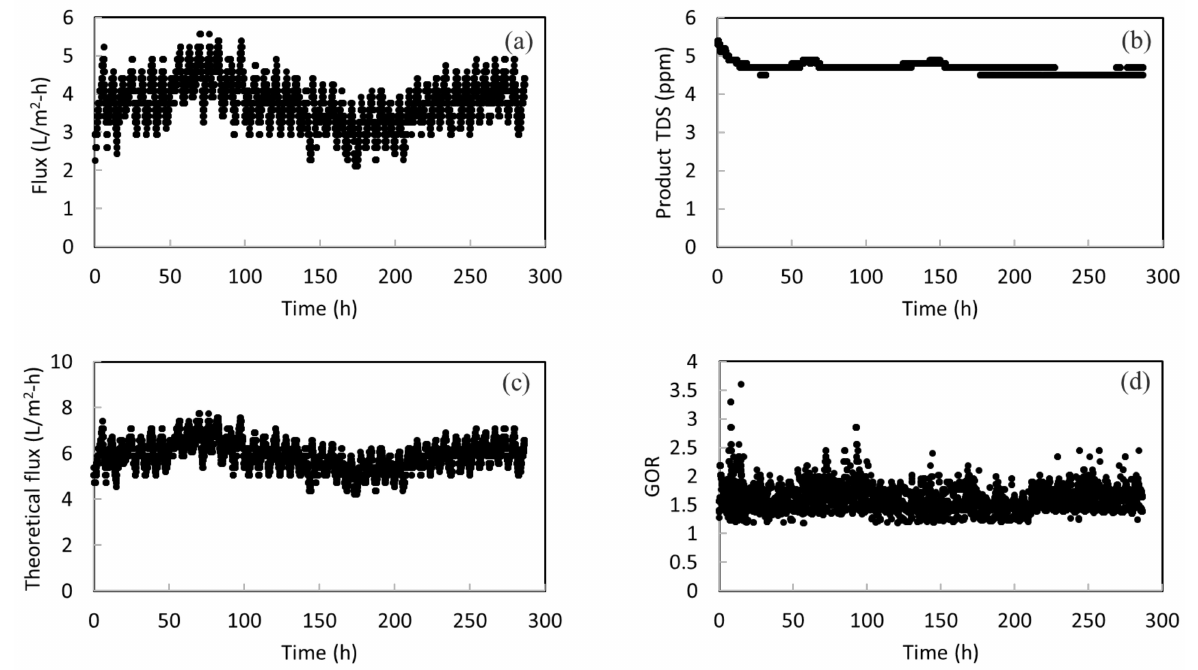
Figure 5. ( a ) The permeate flux for the pilot-scale testing; ( b ) the total dissolved solids (TDS) amount in the product water; ( c ) the theoretical flux calculated for the pilot-scale testing; and ( d ) the GOR of the system with heat recovery from the